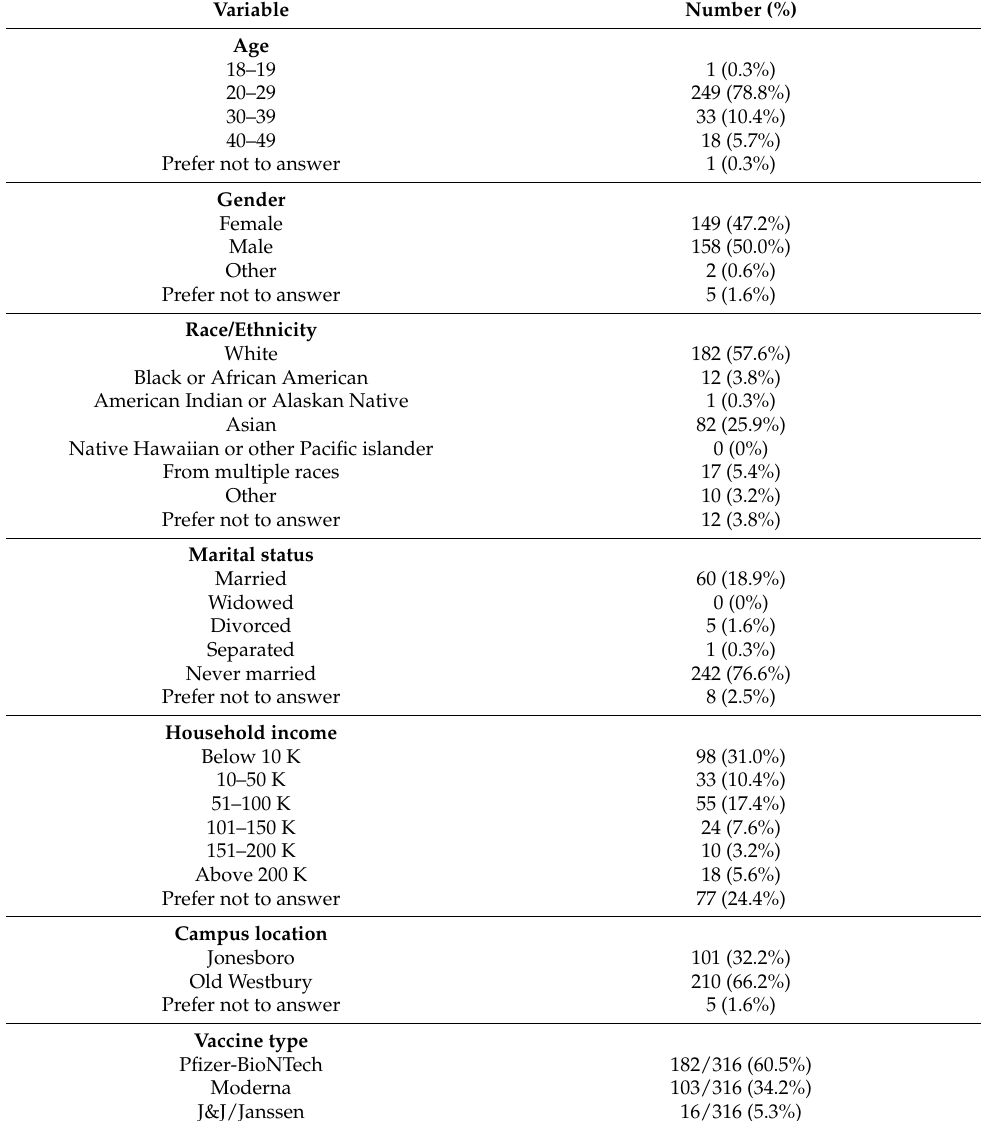
Table 1. Characteristics of study participants (N =